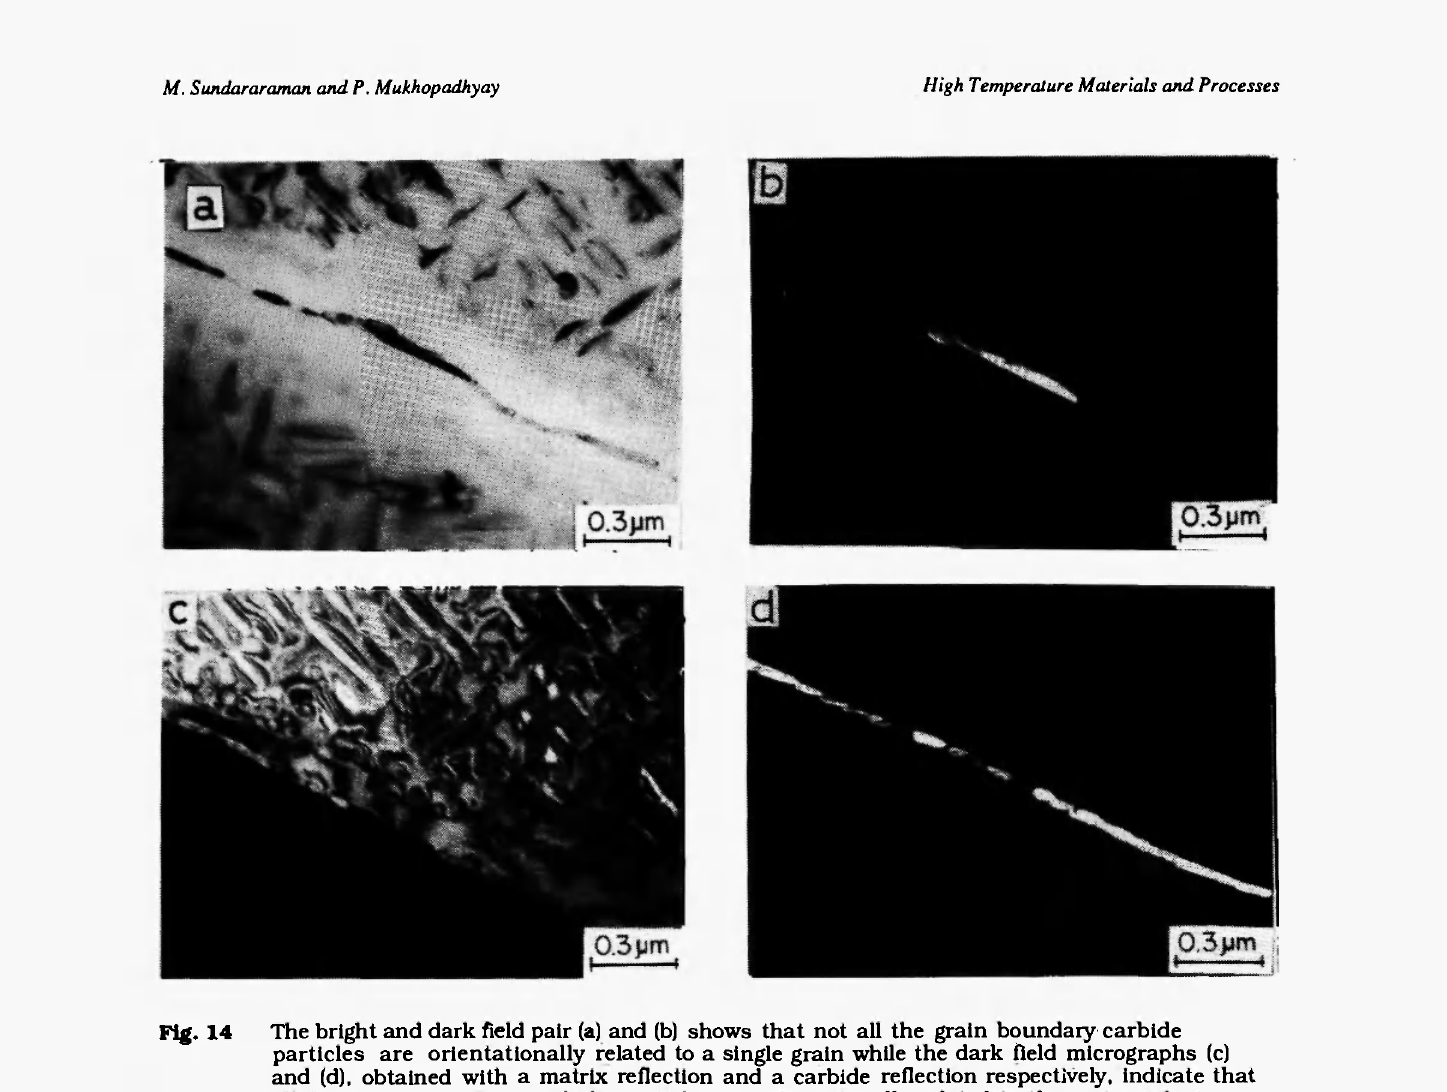
Fig. 14 The bright and dark field pair (a) and (b) shows that not all the grain boundary carbide particles are orientationally related to a single grain while the dark field micrographs (c) and (d), obtained with a matrix reflection and a carbide reflection respectively, indicate that all the grain boundary carbide particles are orientationally related to the grain at the top. summarised in Table 2, in which the average sizes of the grain boundary precipitates are also indicated. The error in the measurement of the particle size, due to specimen tilting effects, was estimated to be within ± 20%. The large scatter in the widths of the PFZ's corresponding to the same ageing treatment reflected the differences in the widths of the PFZ's associated with different grain boundaries. However, it could be seen that at a given ageing temperature the average PFZ width Fig. IS SAD pattern from a large, chunky grain increased with increasing ageing time, or in other boundary carbide precipitate (different from MC) In Inconel 718. This pattern words, with increasing grain boundary precipitate could be matched with a <001> SAD pattern from the M23C6 size.